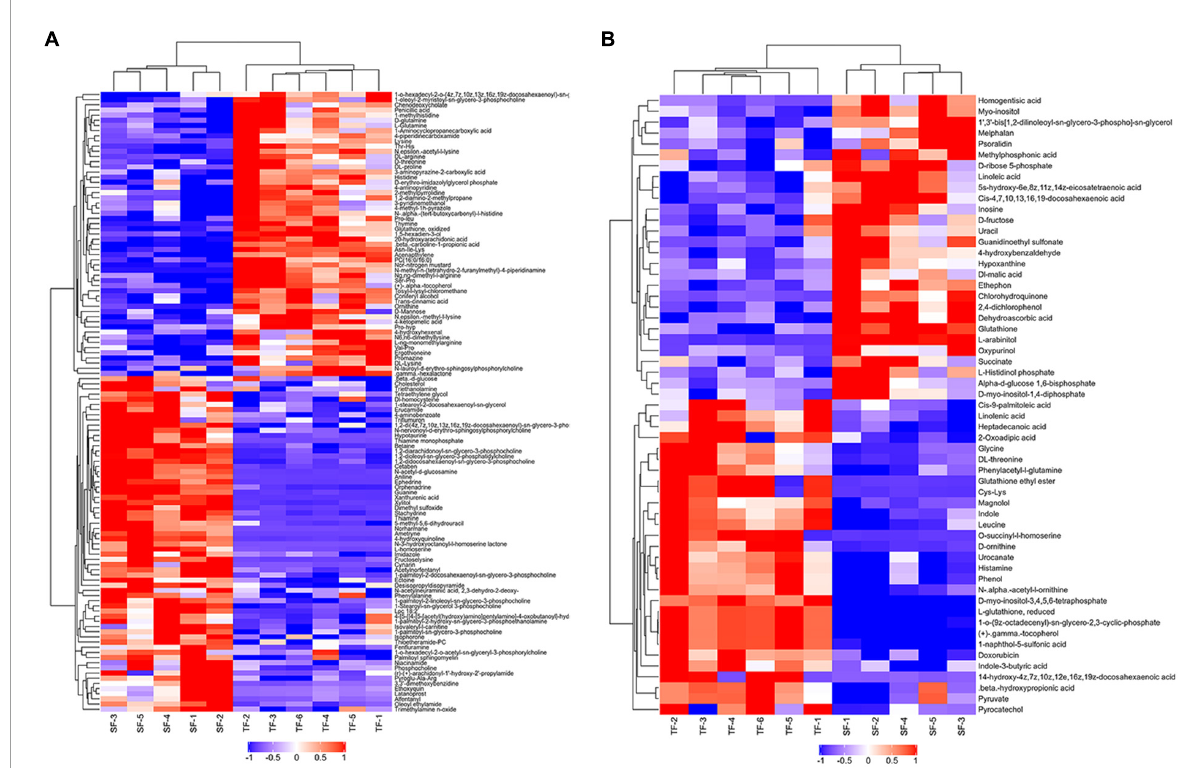
FIGURE3 Hierarchical clustering diagram of metabolites with significant differences between TF and SF group. TF-1 to TF-6: Trash fish group; SF-1 to SF-5: Self-made feed group. Red represented the up-regulated substance, blue represented the down-regulated substance. (A) Positive ion mode; (B) Negative ion